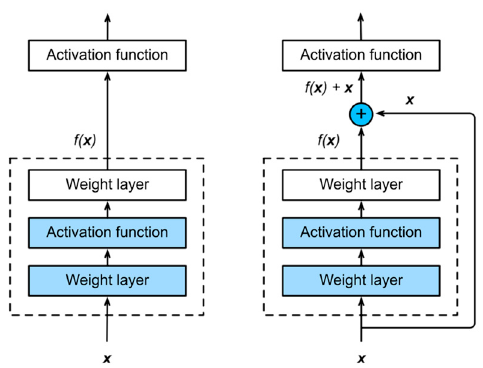
Figure 2. The differences between Convolutional Neural Network in the left side and the Residual Network on the right